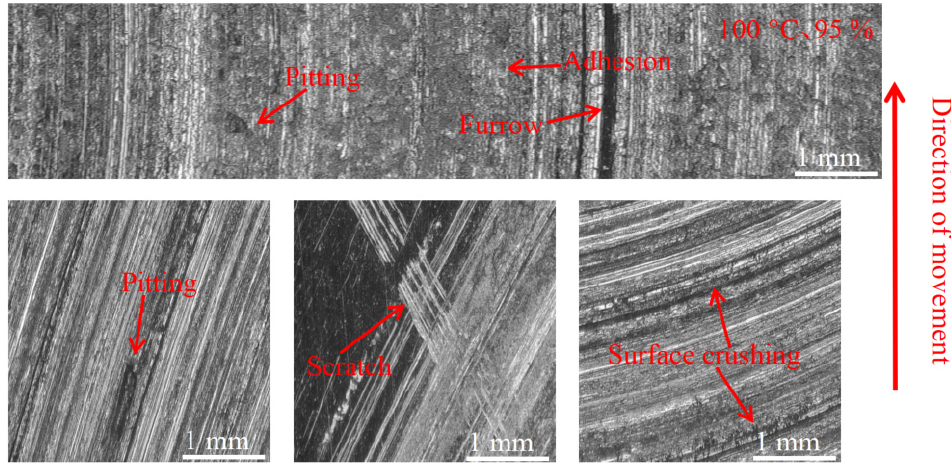
◦ C and 95% ambient humidity.